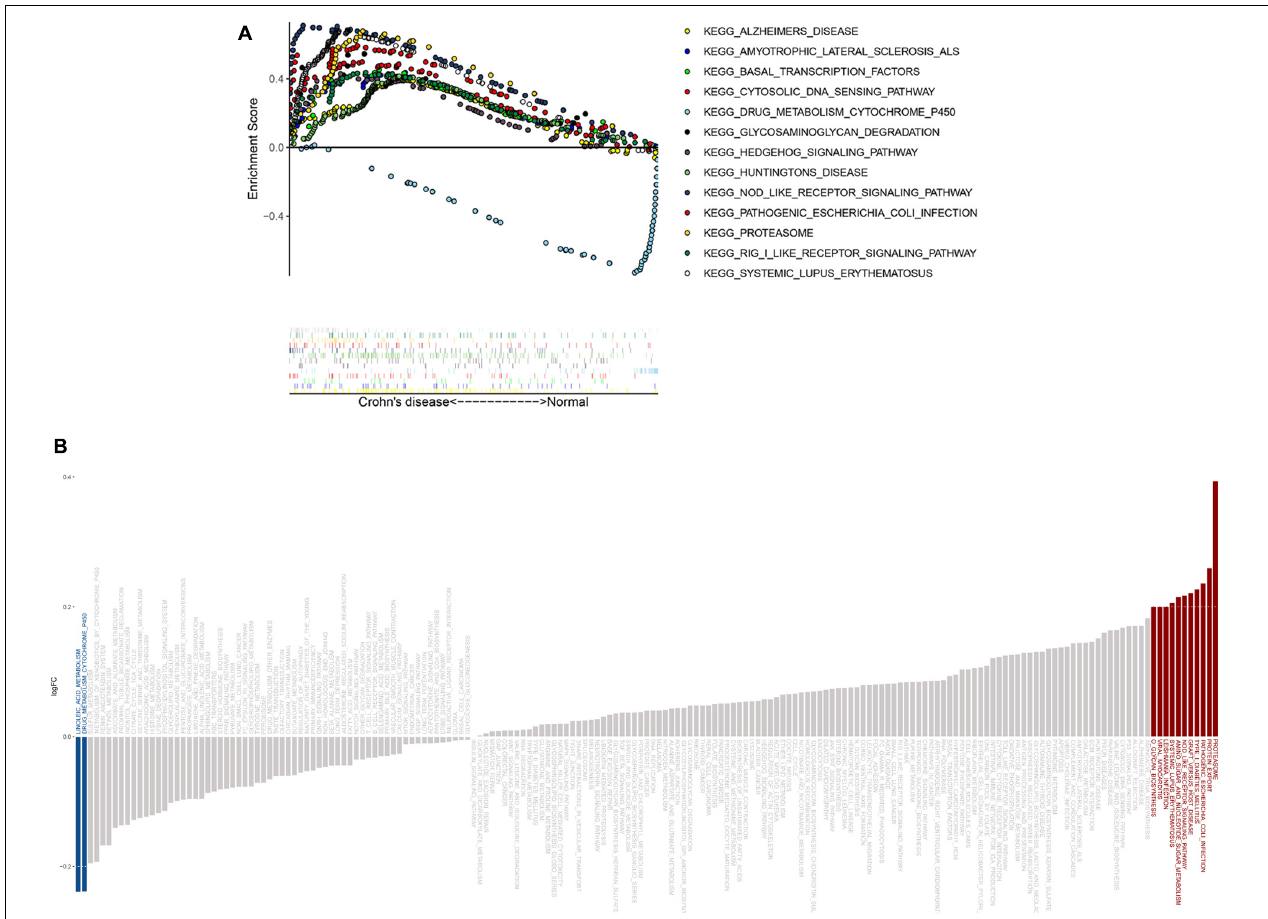
FIGURE 6 | GSEA and GSVA results from the derivation cohort. (A) GSEA revealed that most of the enriched pathways ( P < 0.05) correlated with CD. (B) GSVA showed that most of the significantly altered pathways were activated in